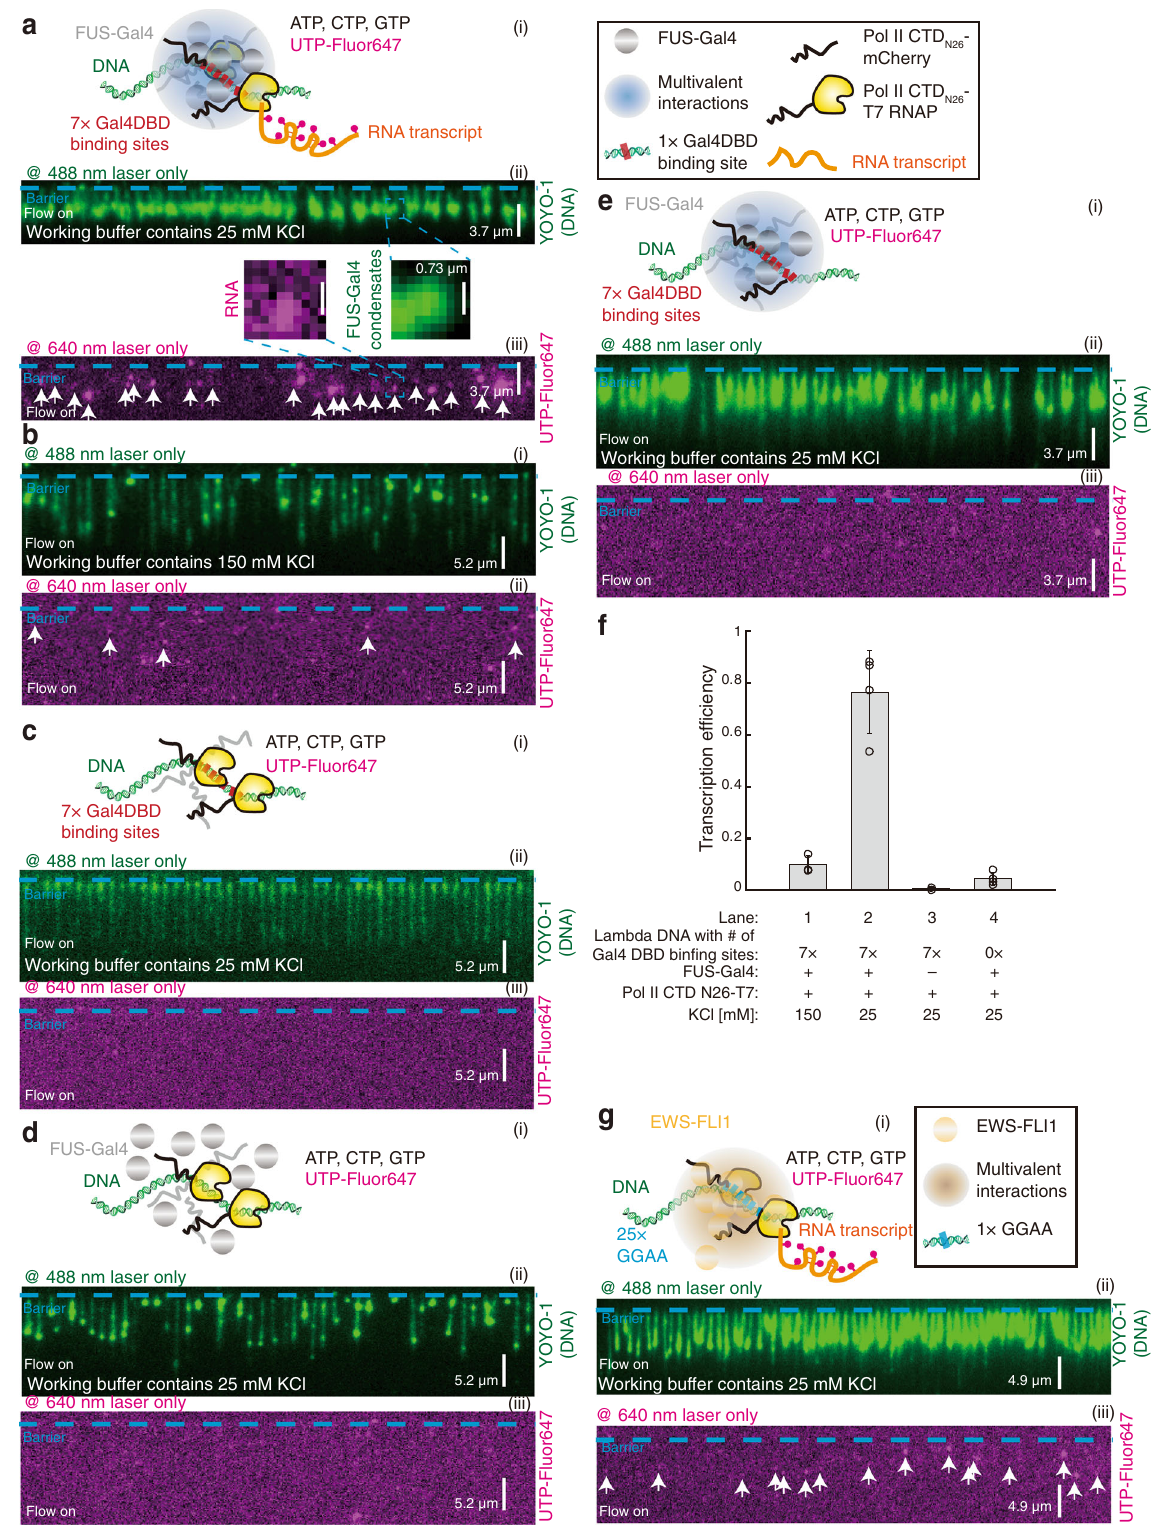
Fig. 10). GFP-FUS-Gal4 formed small droplets at 8 μ M (Sup- plementary Fig. 10a(i)). Mixing GFP-FUS-Gal4 with DNA including varying numbers of Gal4DBD binding sites resulted in larger droplets (Supplementary Fig. 10a, d). The Gal4DBD alone did not form droplets without (Supplementary Fig. 10b) or with